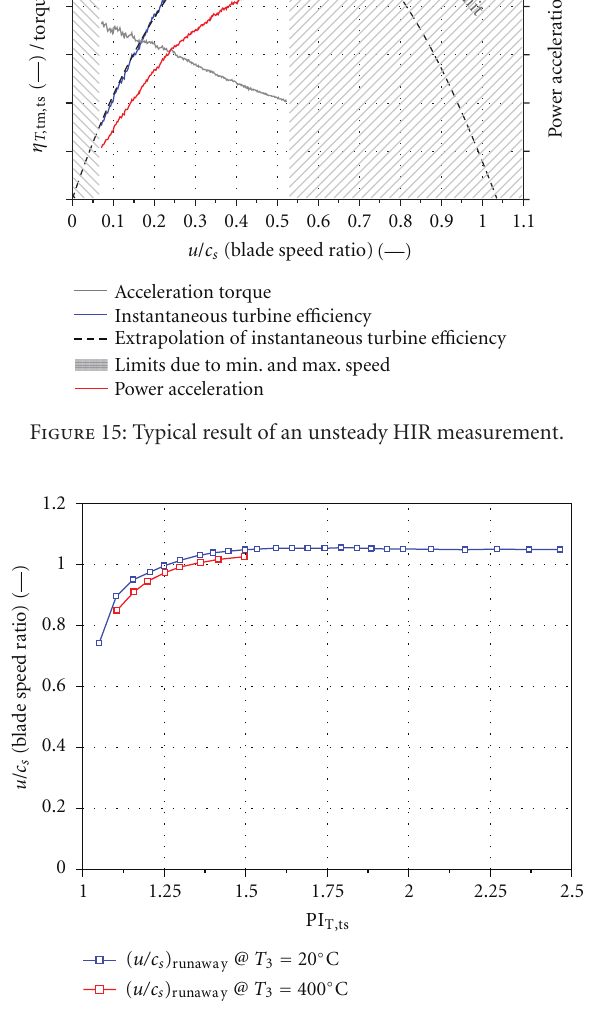
Figure 16: Runaway speed measurements for two turbine inlet